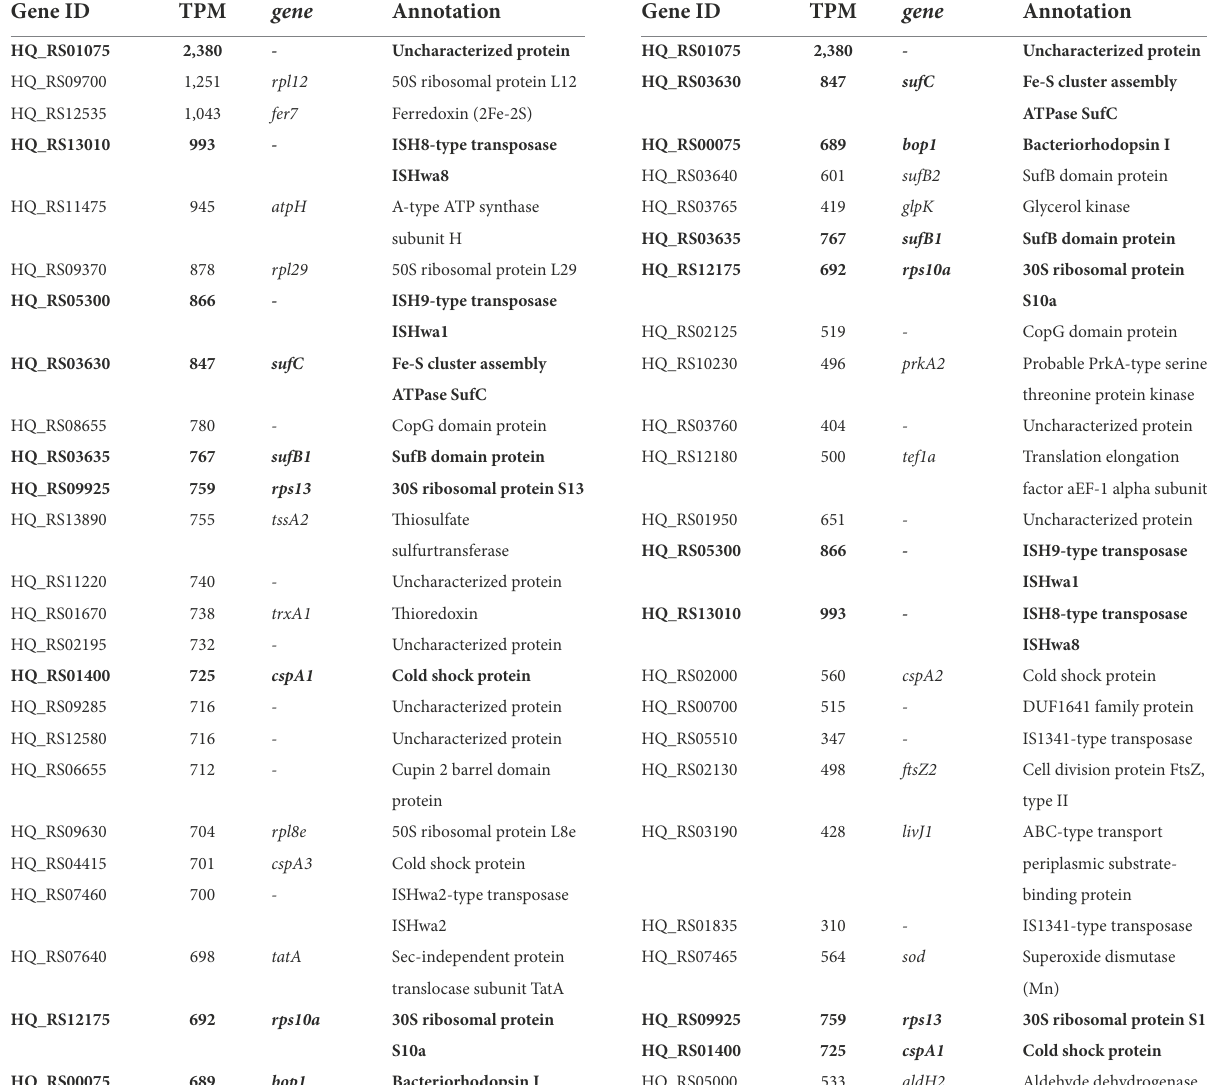
TABLE 3 Top 25 of highest expressed protein coding genes in the winter population of Hqr. walsbyi HBSQ001.